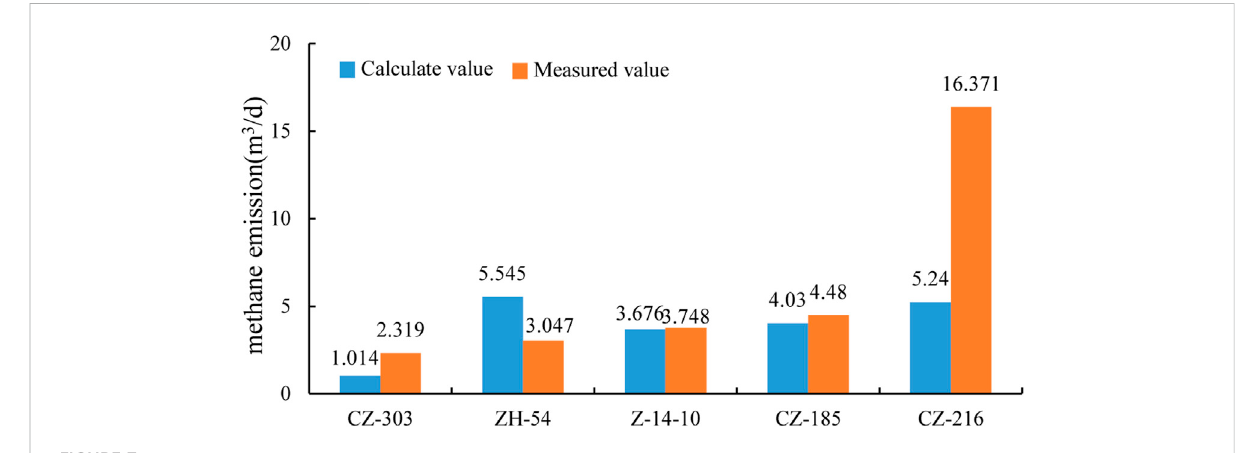
FIGURE 7 Comparison of measured and calculated (the gas-liquid two-phase fl ow